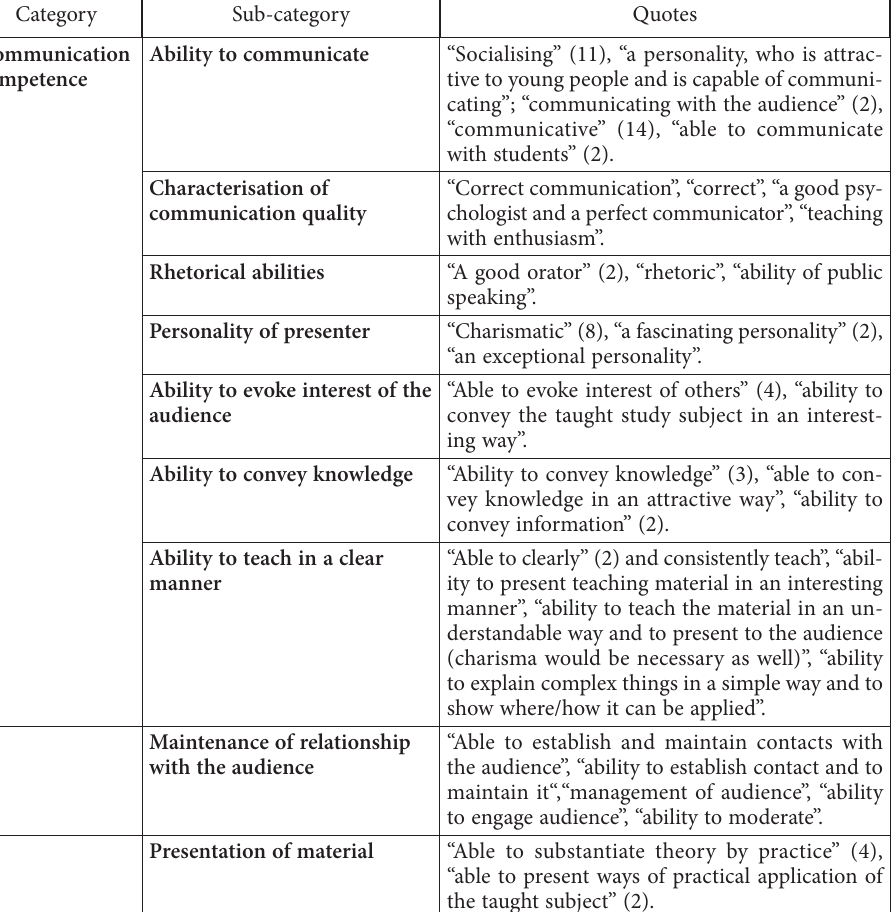
Table 2. The category of communication competence, its subcategory and substantiating quotes (source: created by